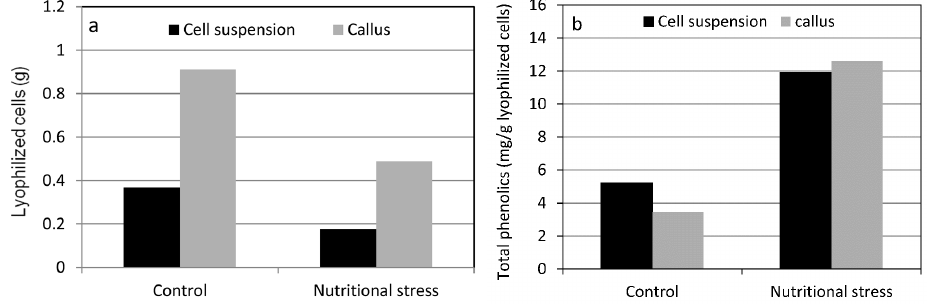
Figure 3. Response of artichoke cells to nutrient deficiency. Cell growth ( a ) and total phenolic content ( b ). Unpublished data.